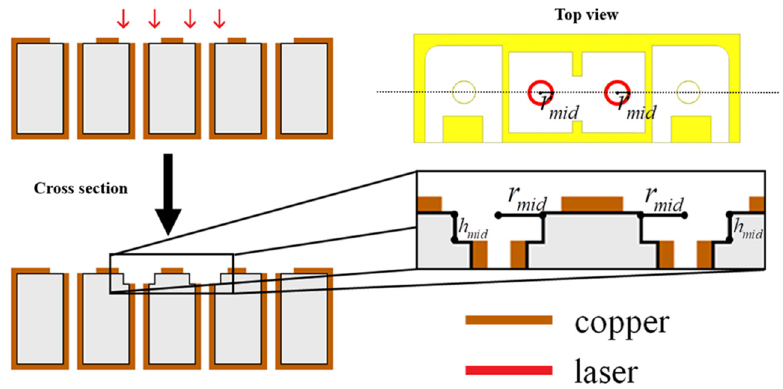
Figure 5. The top view and cross section of laser trimming processes.